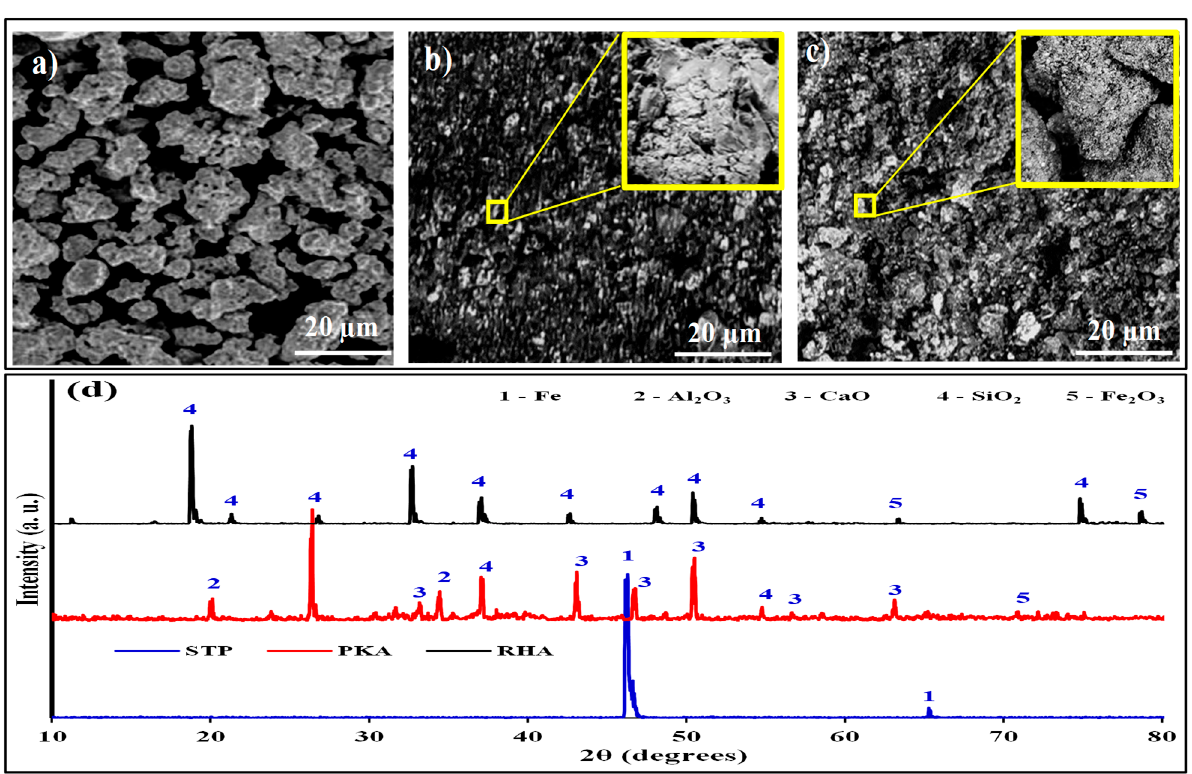
Figure 2. Morphological image of input materials ( a ) steel particles ( b ) palm kernel ash ( c ) rice husk ash and their ( d )